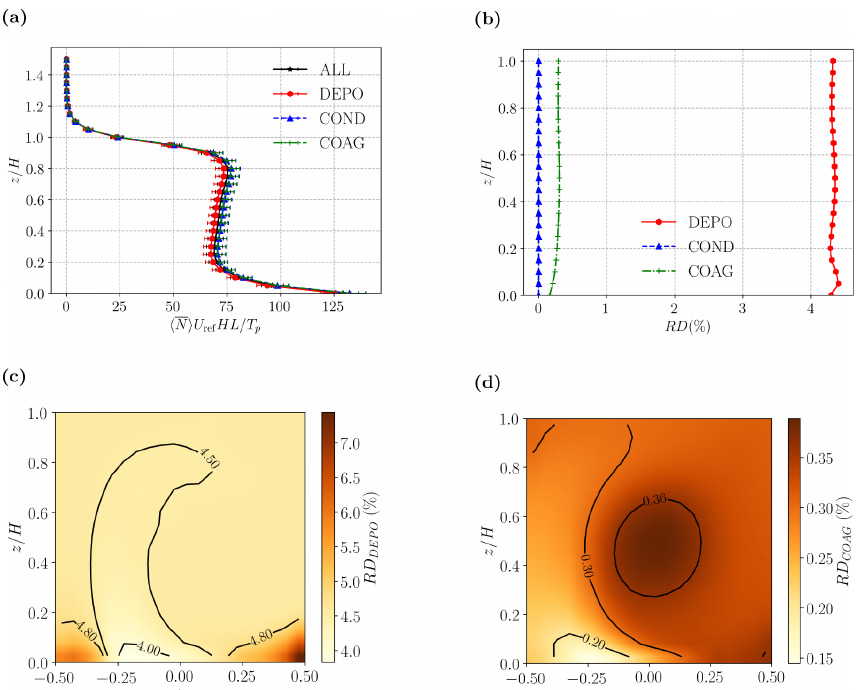
Figure 9. Effect of different aerosol processes for Case TR. Mean vertical profiles of (a) mean aerosol number concentration and (b) relative difference with respect to a simulation without aerosol dynamic processes (NOAD). Spanwise-averaged relative difference fields for (c) de- position and (d) coagulation. The lines correspond to different SALSA configurations (DEPO – deposition only; COND – condensation only; COAG – coagulation only; ALL – deposition, condensation and